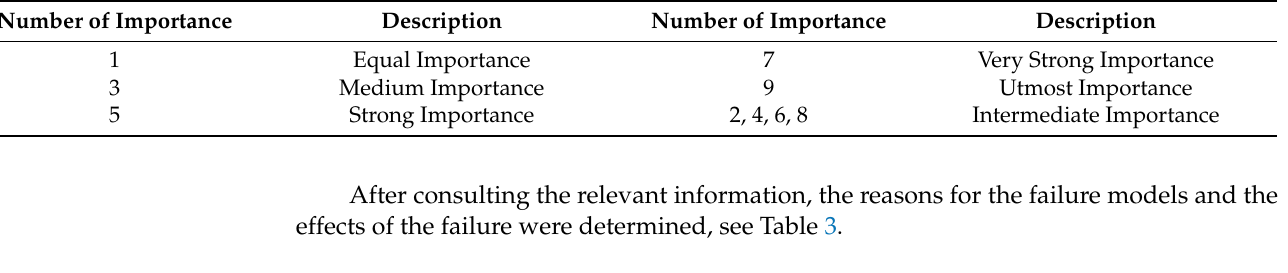
Table 3. Failure modes and reason of the Logistic